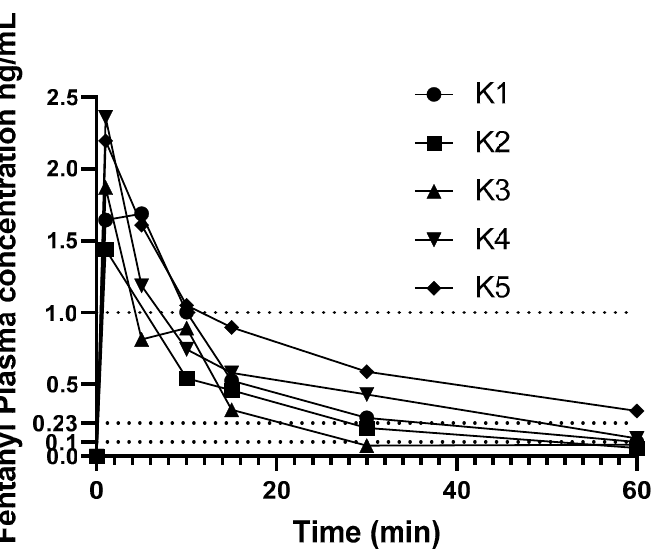
Figure 2. Change in fentanyl plasma concentration over time in minutes. Koala 1 dosed at 10 µ g/kg the other five koalas were dosed at 5 µ g/kg. Dotted lines at 0.23 and 1.0 ng/mL denote suggested analgesic range (see Discussion). Additional dotted line at 0.1 ng/mL denotes assay LLOQ. Table 1. Pharmacokinetic parameters and indices calculated from a non ‐ compartment analysis following administration of a single i.v. 5 mg/kg bolus dose of fentanyl.